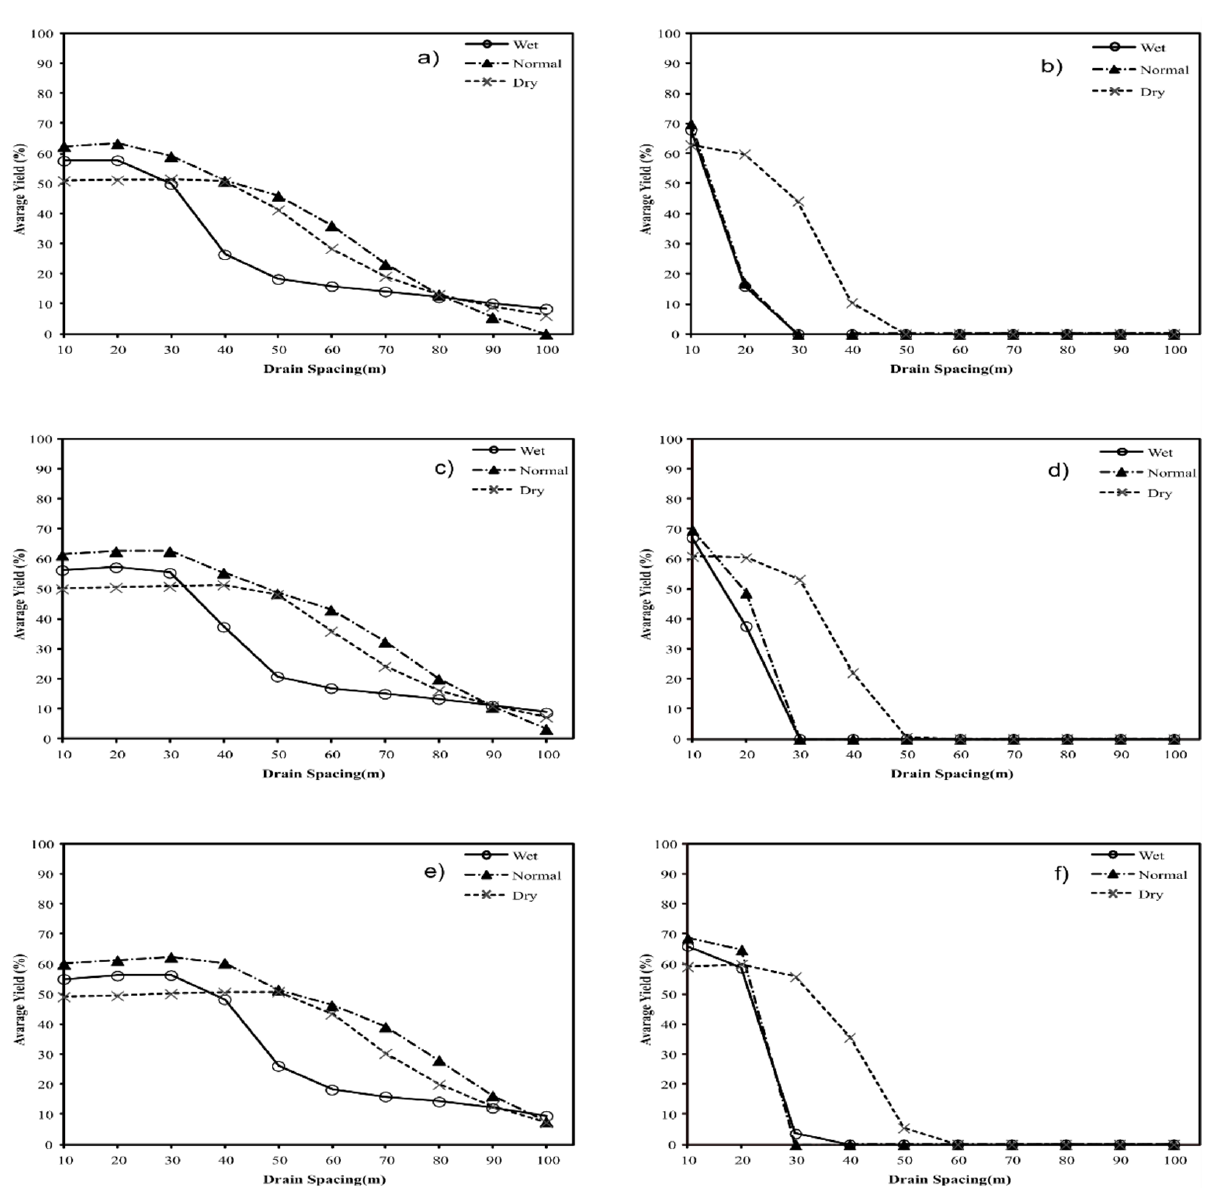
Figure 6. Yield of sugarcane (YT), for normal rainfall and dry and wet years, for drain spaces varying from 10 to 100 m for soil 1 anddrain depths of 1.2 ( a , b ), 1.4 ( c , d ) and 1.6 ( e , f ) m for the Barinas ( a , c , e ) and Turen ( b , d , f ) weather stations.